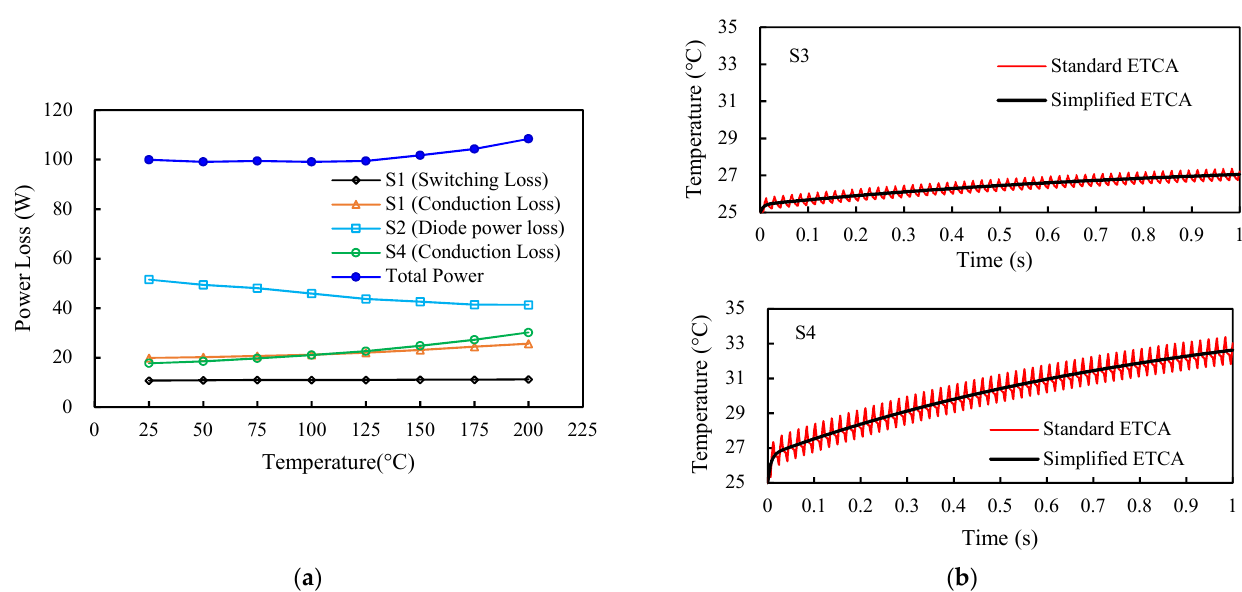
Figure 9. ( a )Temperature-power loss dependence in the first switching state and ( b ) a comparison of the transient maximum junction temperatures of the switches S 3 and S 4 for the standard and proposed ETCAs during a one-second operation.